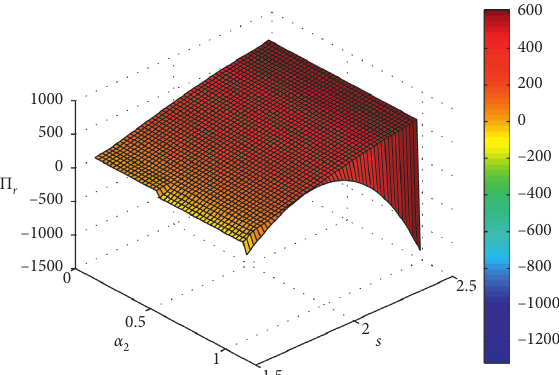
Figure 20: 3D profit diagram for the retailer with α